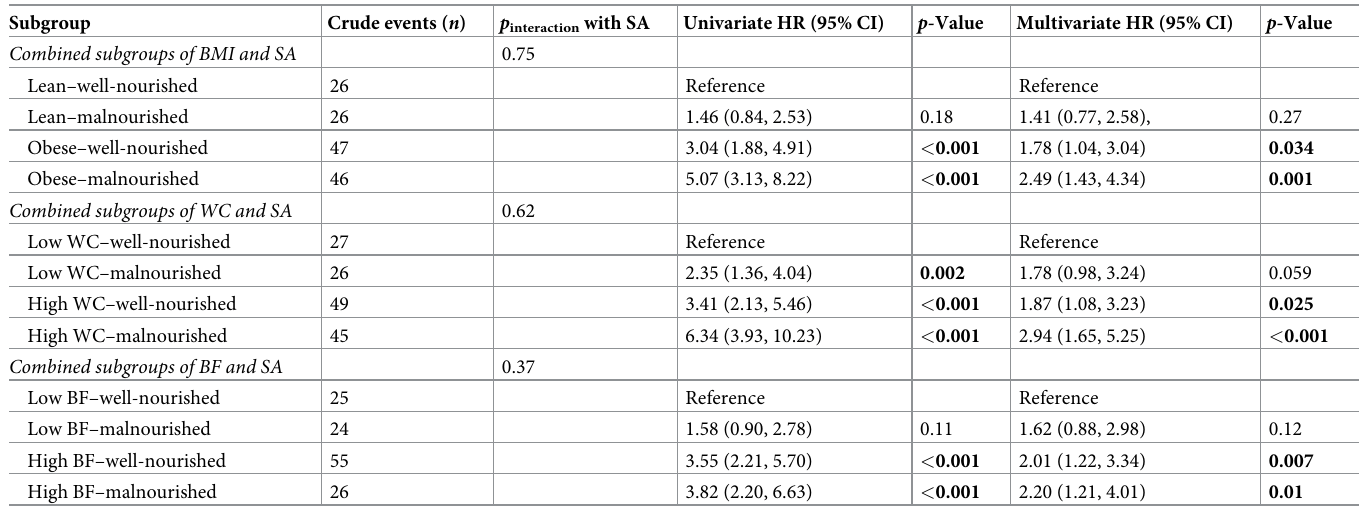
Table 3. Association of subgroups of obesity measures and SA with the composite outcome (heart failure hospitalization and all-cause mortality) ( n = 145). Subgroup Crude events ( n ) p interaction with